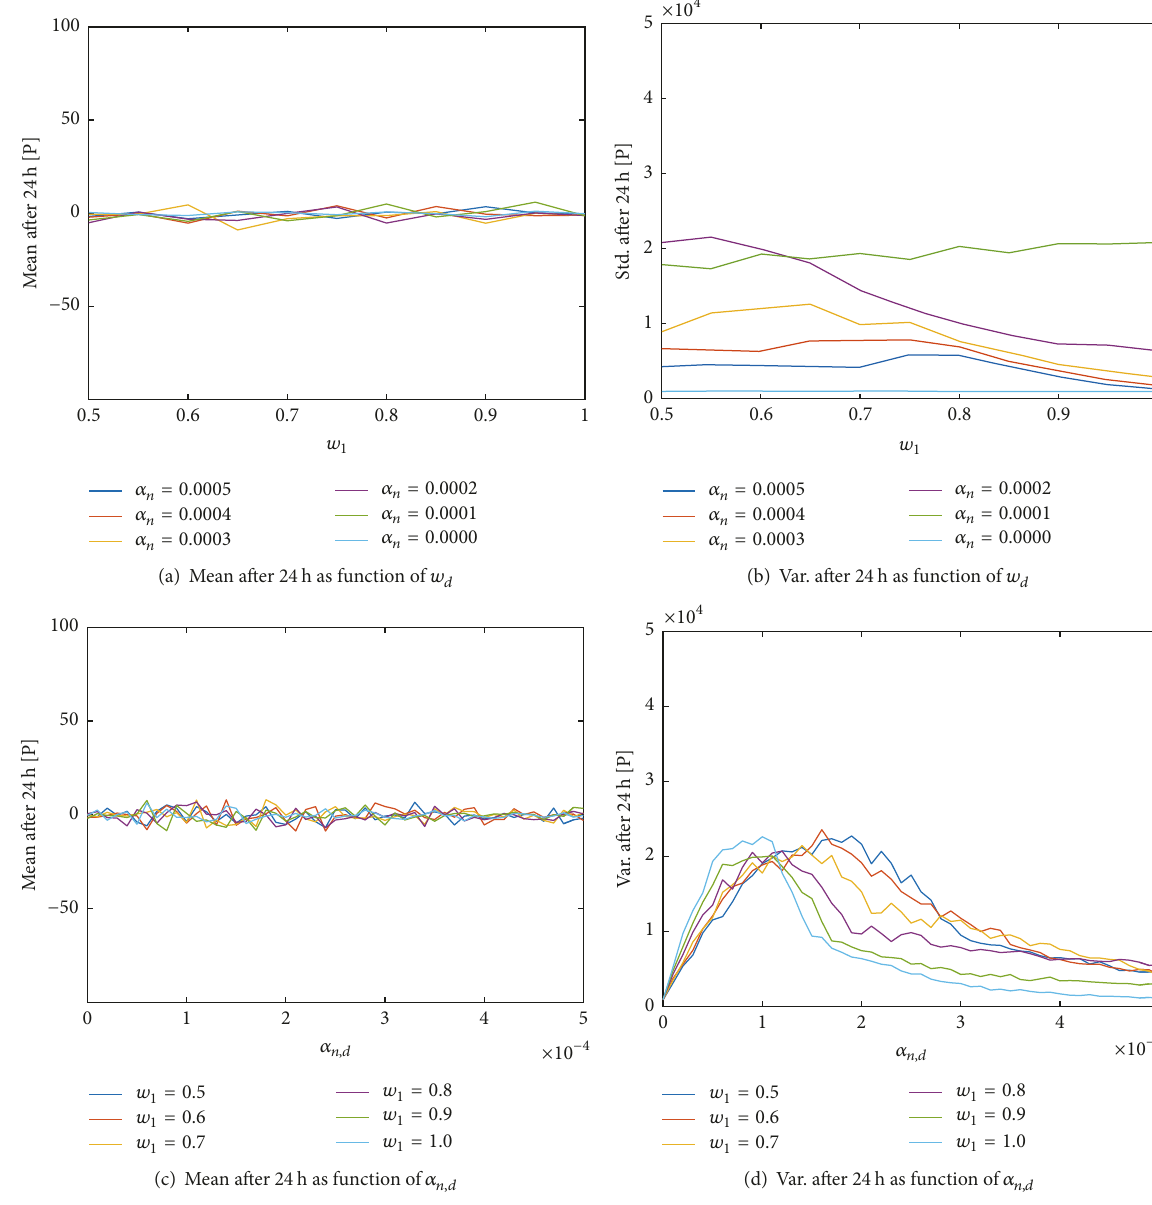
Figure 8: Case 2: visualisation of mean and standard deviation of the number of pedestrians in the region given a certain distribution over the entrances as a function of 𝑤 𝑑 and 𝛼 𝑛,𝑑